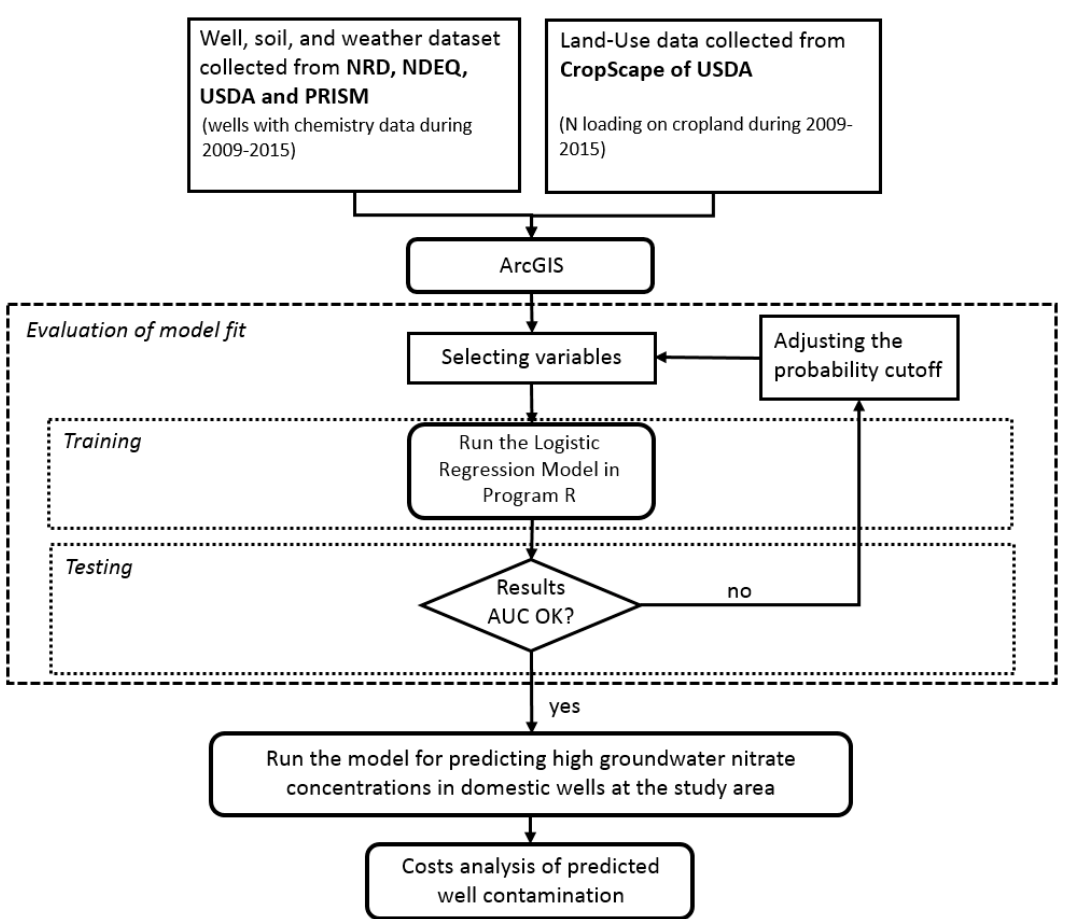
Figure 2. Overview of the methodology for this study.